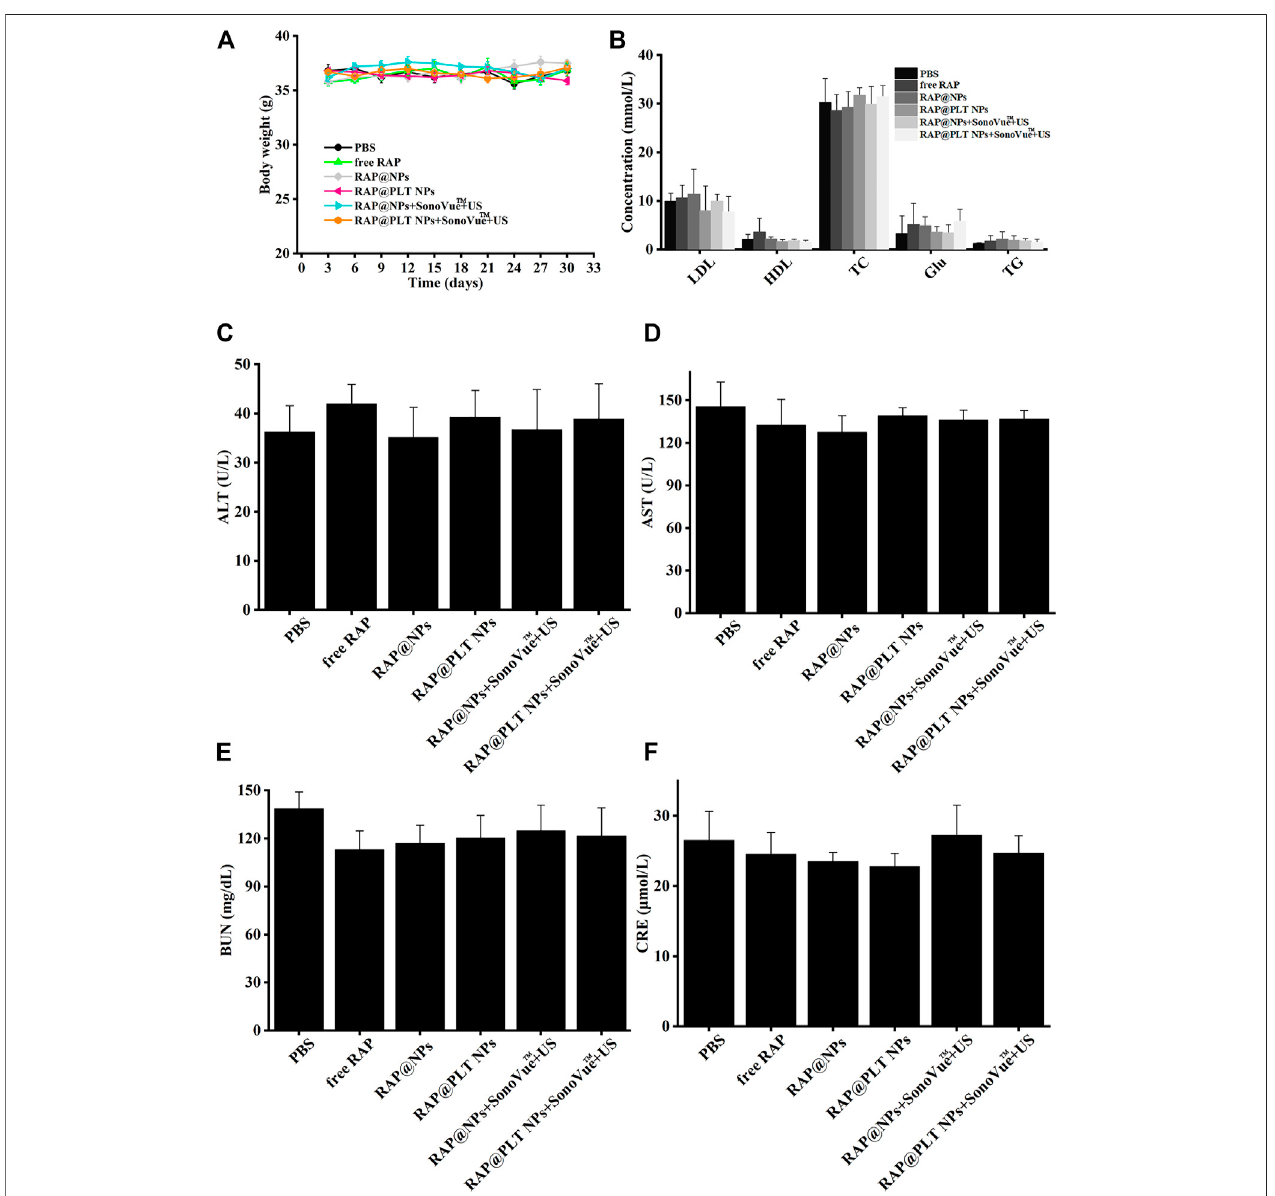
FIGURE 10 | Biosafety analysis of ApoE − /- mice after different treatment at day 30. (A) The body weight of ApoE − / − mice during various treatments. (B) The lipid pro fi le of ApoE − /- mice after different treatment. (C – F) The biochemical assays of hepatic and kidney functions. ALT, alanine aminotransferase; AST, aspartate aminotransferase; URN, blood urea nitrogen; and CRE, creatinine. n = 5, mean ± SD.